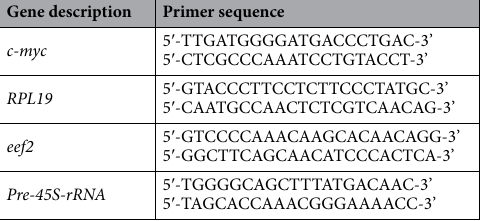
Table 1. Primers used for